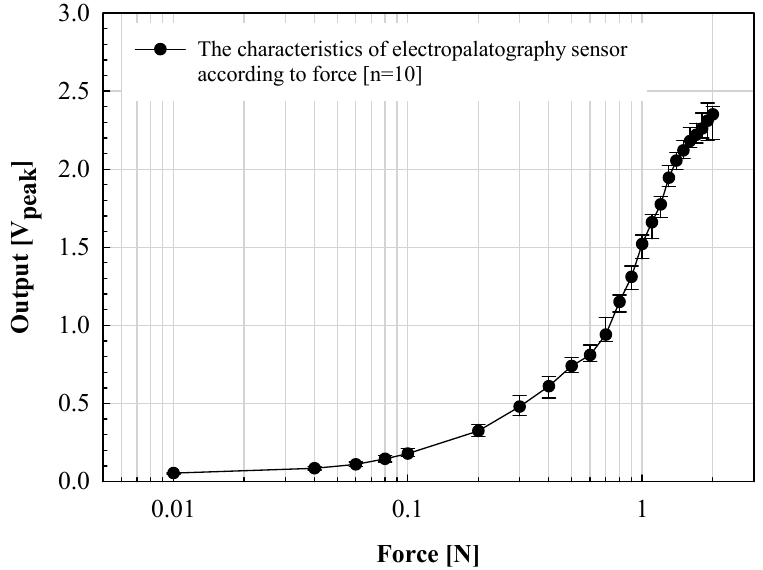
Figure 7. Verification of the proposed electropalatography sensor according to the force applica- tion.